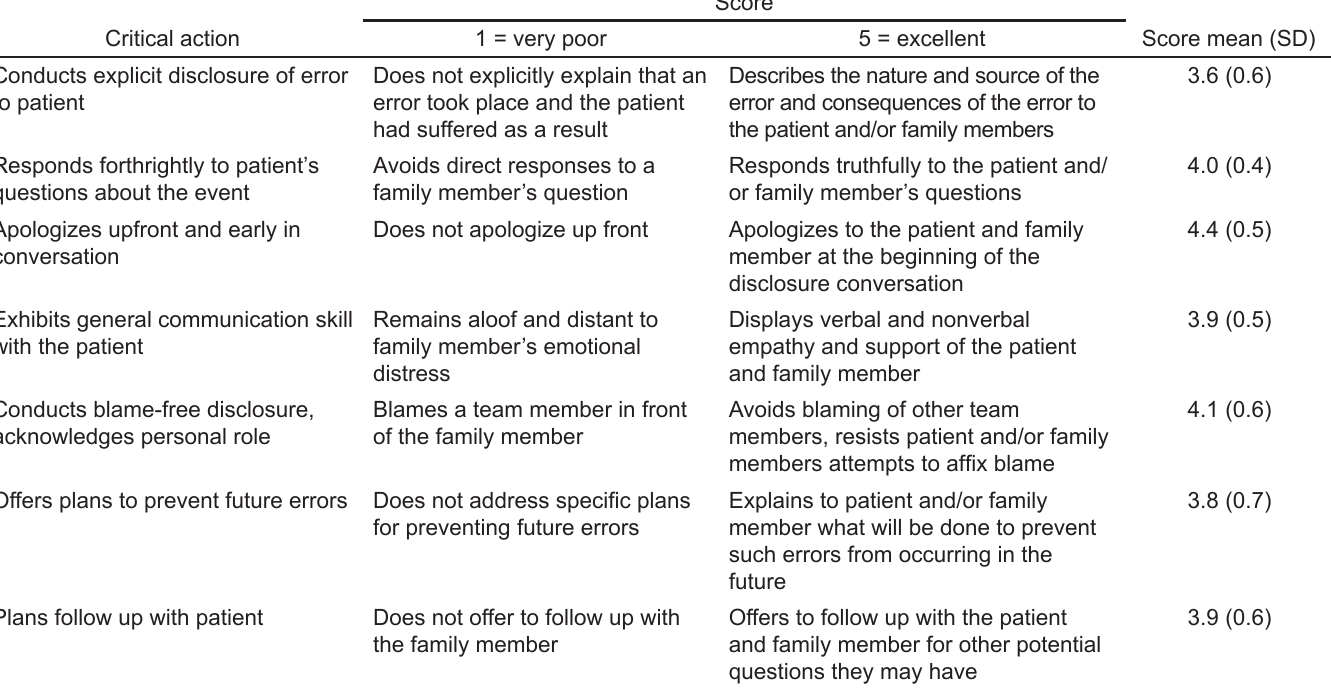
Adapted from Kim et al. Teaching and Learning in Medicine 2011;23(1):68 and Biberston K et al. Error Communication: Discover barri- ers, Share best practices and Lead change with simulation. IMSH